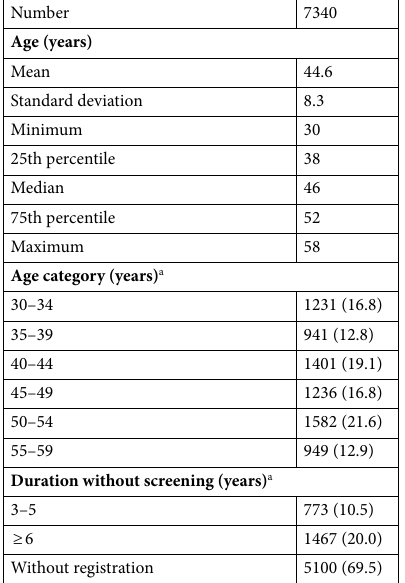
Table 1. Participants’ background characteristics in the self-sampling arm. a Number (percentage) is shown.